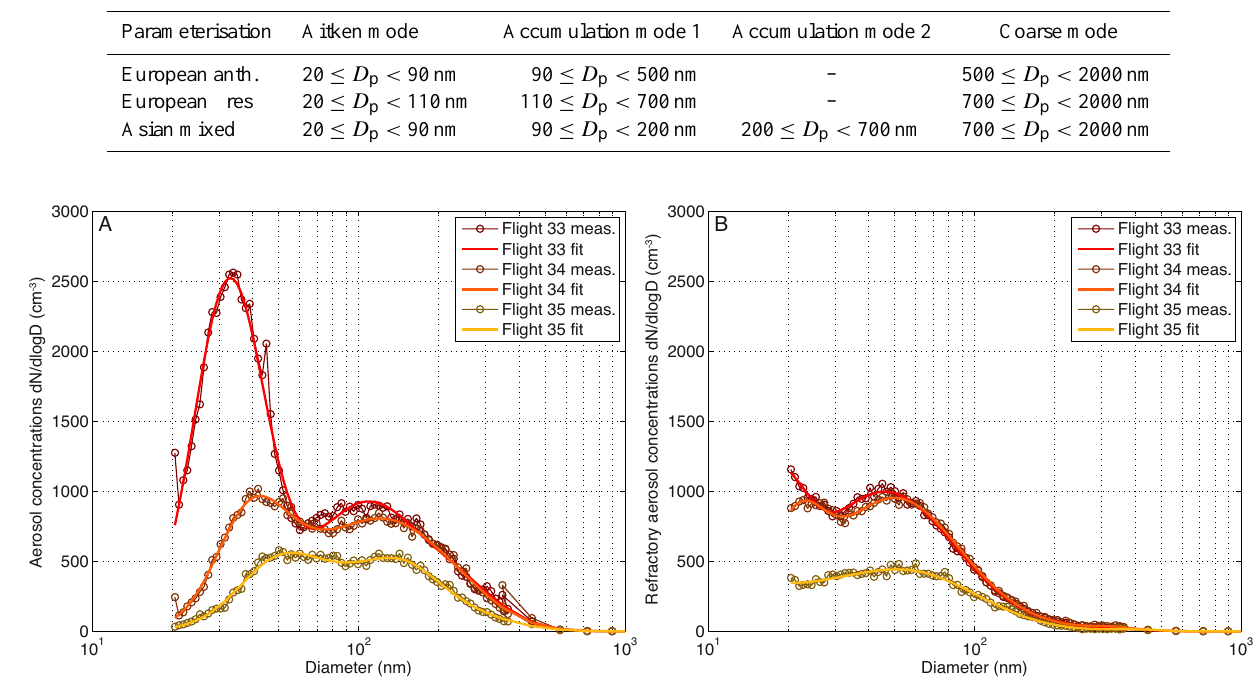
Fig. 6. (A) Ambient and (B) 280 ◦ C aerosol number size distributions for flights on 9, 10 and 11